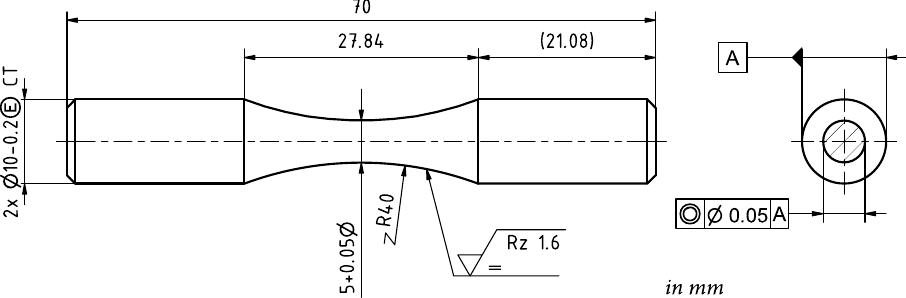
Figure 2. Technical drawing of the fatigue specimen for rotating bending.